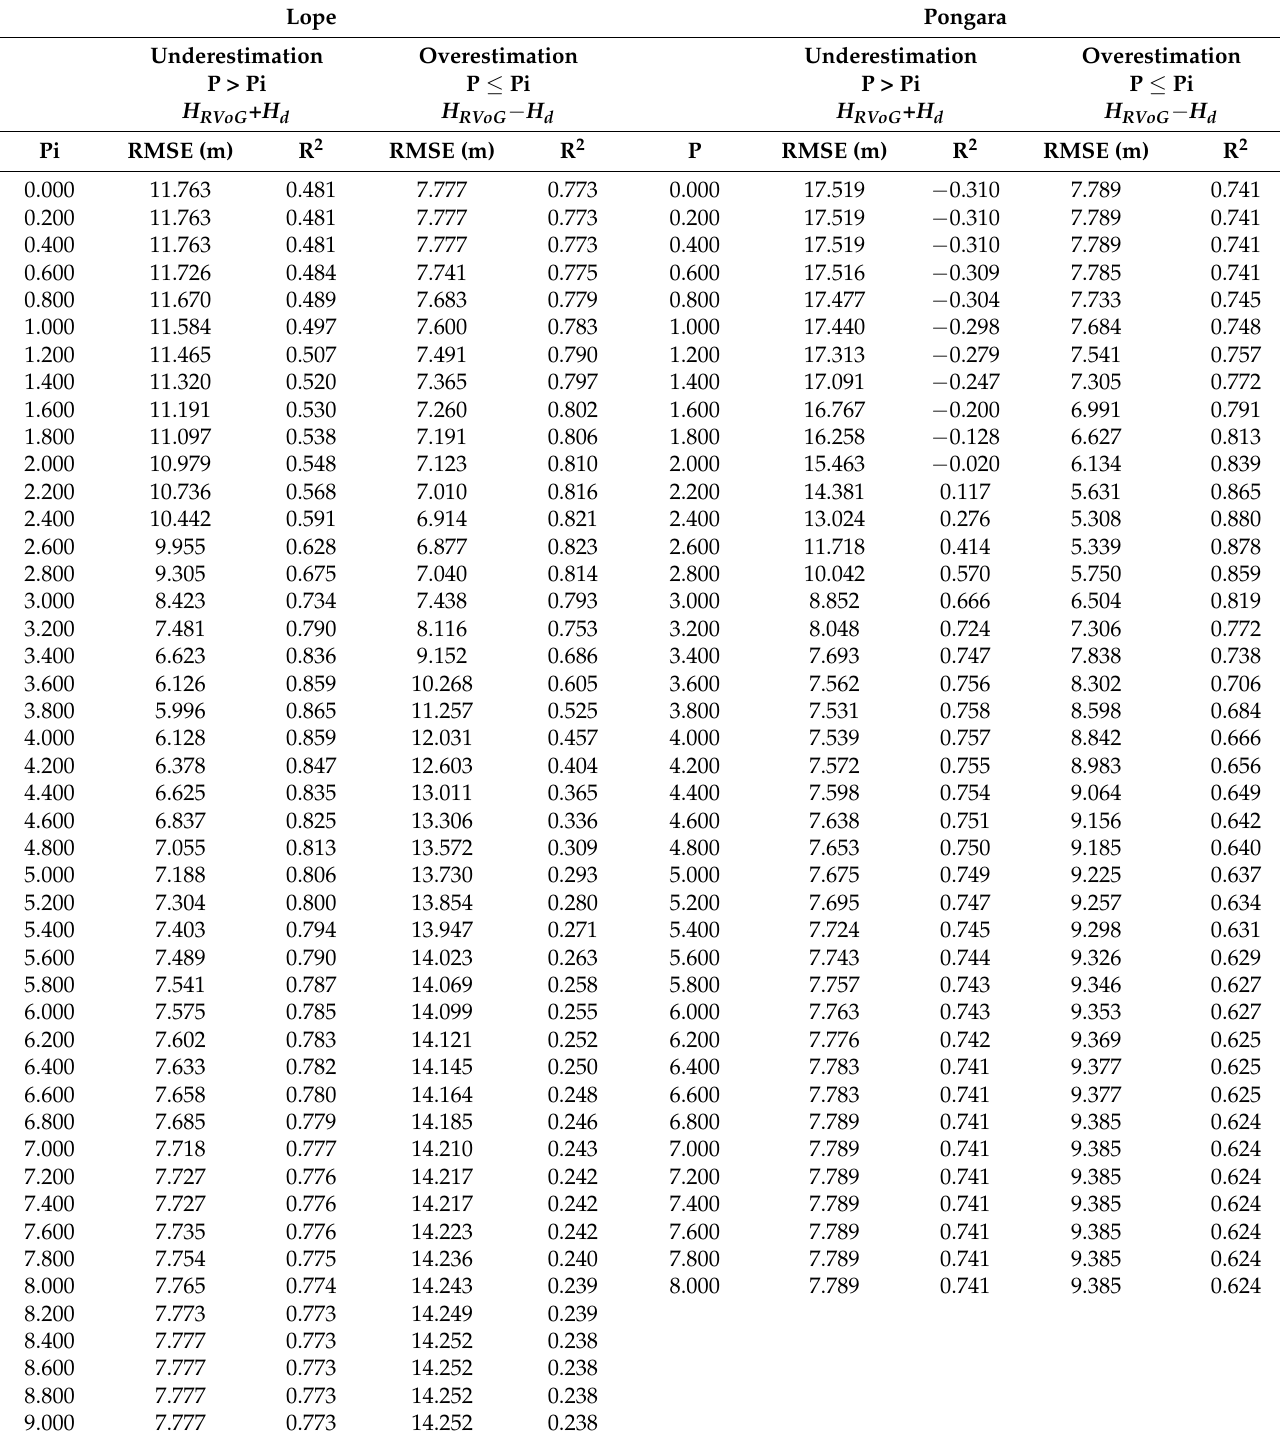
Table 4. Iteration results based on p